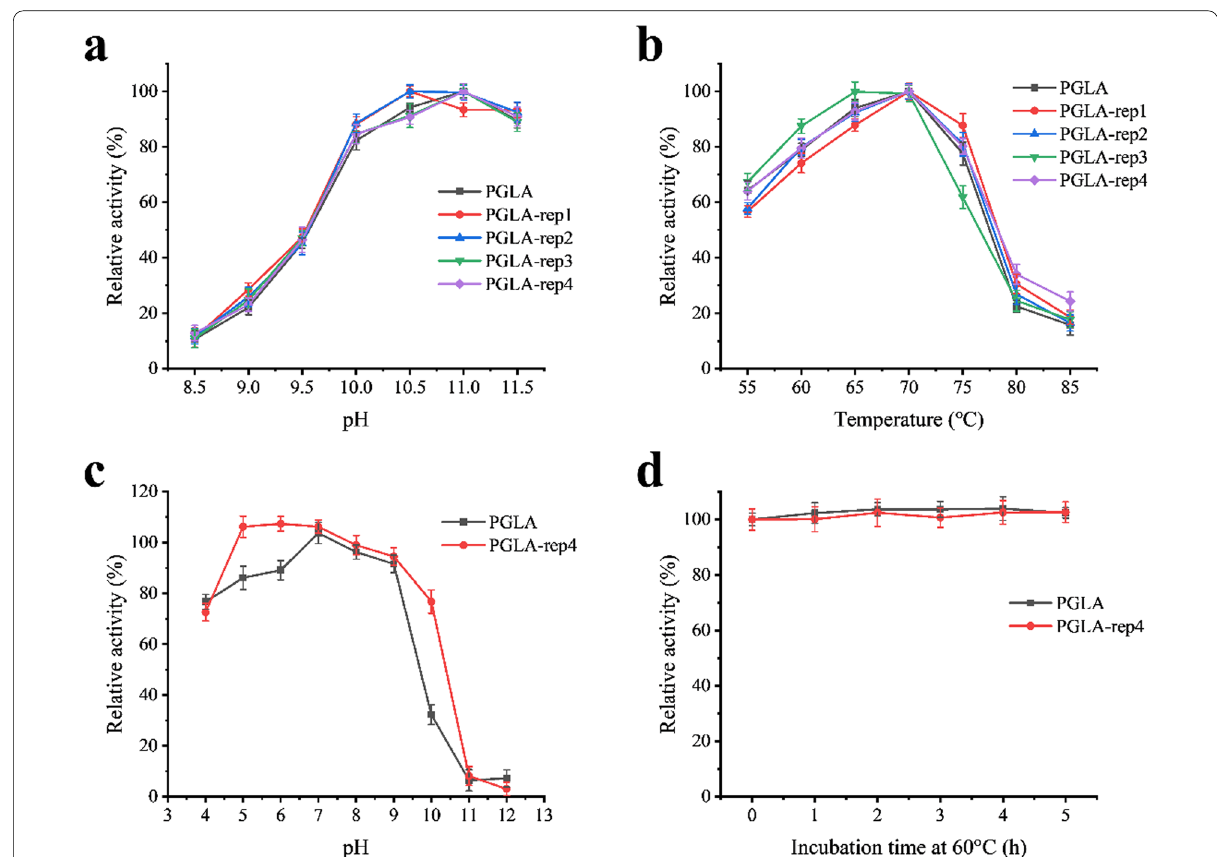
Fig. 2 pH and temperature profiles of alkaline pectin lyase, a Optimum pH, b Optimum temperature, c Stability of PGLA and PGLA‑rep4 at pH range, d Thermal stability of PGLA and PGLA‑rep4 in glycine‑NaOH buffer (pH 11.0) at 60 °C—the activities of all enzymes were determined under standard enzyme assay conditions using 0.2% apple pectin as substrate and all data are presented as the mean of three experiments; error bars represent standard